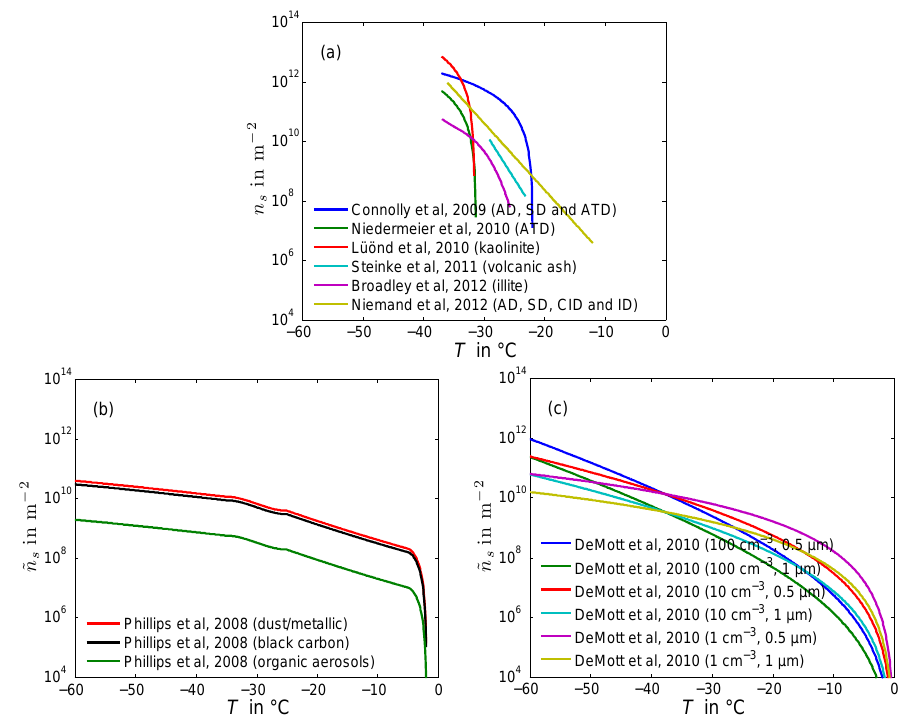
Fig. 17. (a) Parameterizations of n s for immersion freezing. (b) Equivalent ˜ n s from Phillips et al. (2008) evaluated at water saturation. (c) Equivalent ˜ n s derived from DeMott et al. (2010) for different concentrations and monodisperse